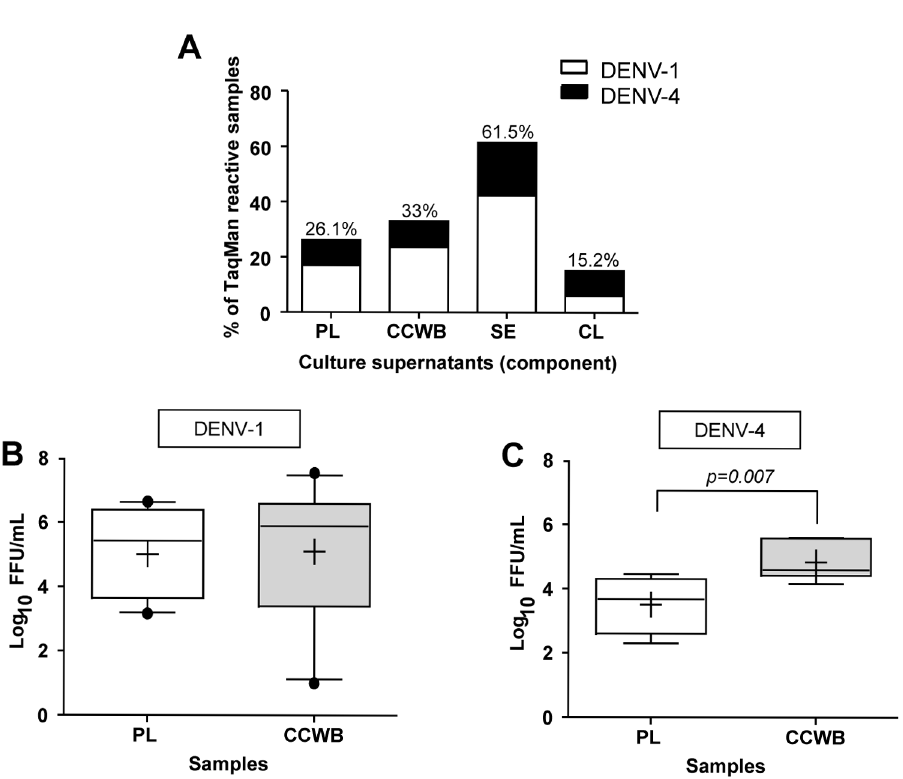
Fig 4. Culture of DENV-positive blood components. A) Percentage of TaqMan-reactive cell culture supernatant from mosquito C6/36 cells infected with plasma (PL), the cellular component of whole blood (CCWB), serum (SE) or homogenized clots (CL) from samples from Puerto Rican blood donors, 2012 – 2013. B) Infectivity titers of DENV-1-positive PL or CCWB from samples from infected Puerto Rican blood donors, 2012 – 2013, in supernatants from a single passage in cultured mosquito C6/36 cells. C) Infectivity titers of DENV-4-positive PL or CCWB from samples from infected Puerto Rican blood donors, 2012 – 2013, in supernatants from a single passage in cultured mosquito C6/36 cells. For both B) and C), whiskers represent 10-90th percentile. Outliers are shown as black dots. Mean is shown as a “ + ” sign and median as a horizontal line inside the box.